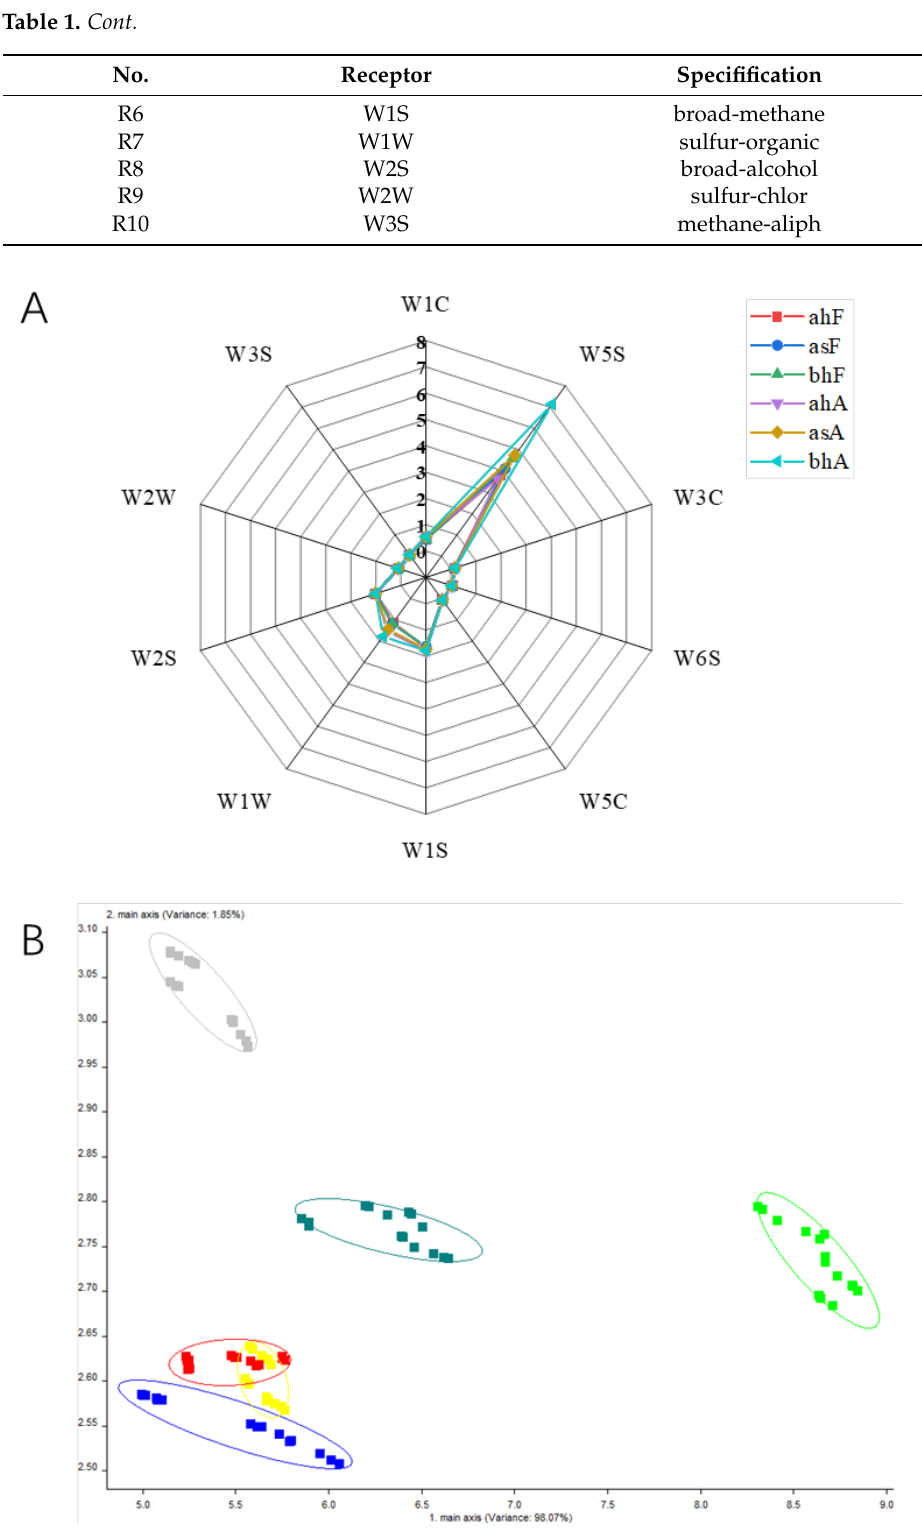
Figure 2. Radar chart and PCA analysis by E-nose. ( A ) Radar chart of the E-nose response of differ- ent types of volatiles for different pasteurized yogurt samples, ( B ) PCA plot of the E-nose for different pasteurized yogurt samples.